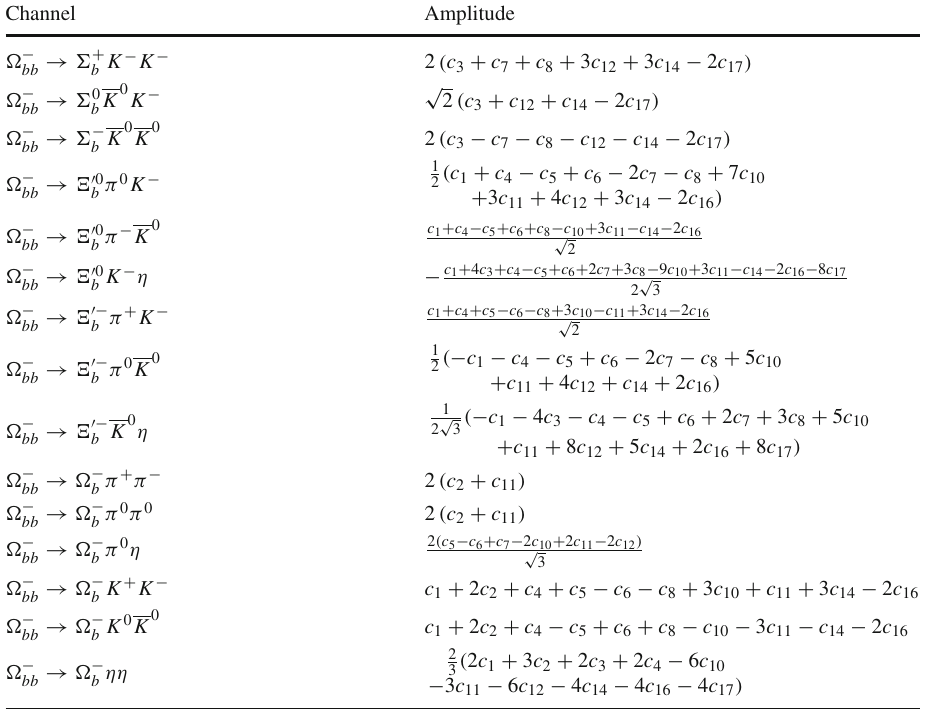
Table 27 Doubly bottom baryon decays into a bqq (sextet) induced by the charmless b → s transition and two light mesons